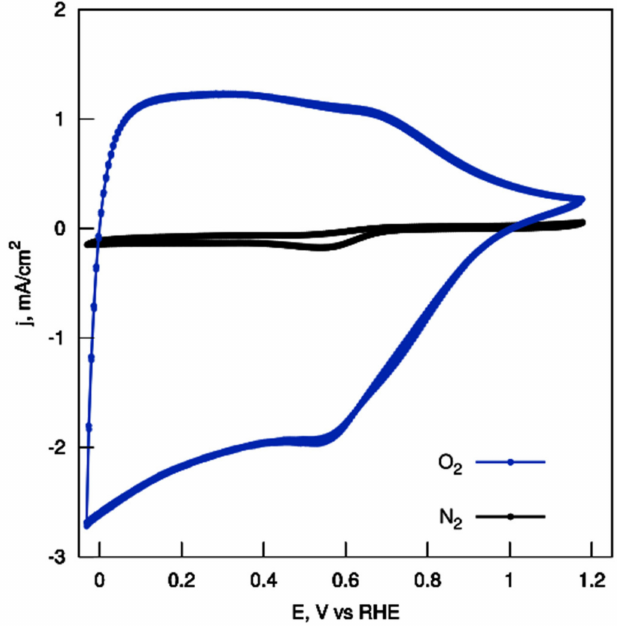
Figure 8. CV measurements at a scan rate of 10 mV s − 1 for CH_K.